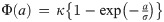
Family of curves used to model annual apparent survival as a function of age in the Φ(curve) models.The models follow the equations, Φ(a)=κ{1−exp(−aσ)}, where κ represents adult survival (κ = 0.98 in curves shown here) and σ controls the speed at which adult survival is attained. Curves where σ<1.0 fit the data best, indicating survival plateaued at a young age, compared with σ = 3.0 where survival plateaus at around age 8.